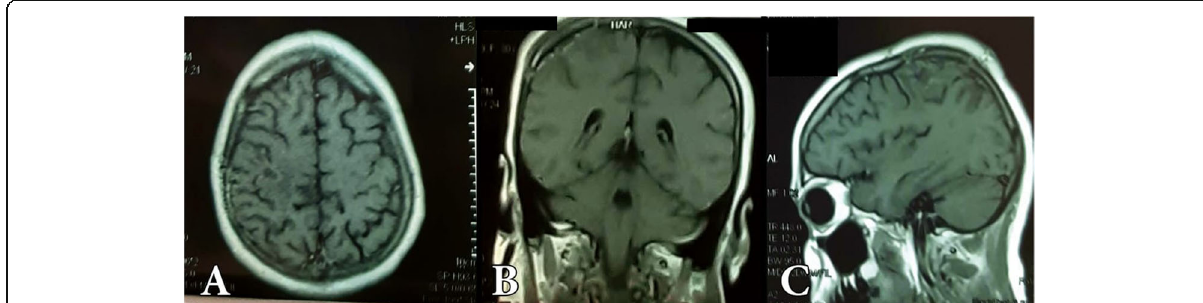
Fig. 6 Postoperative MRI with gadolinium of the same patient in axial ( A ), coronal ( B ), and sagittal ( C ) projections showing total tumor resection